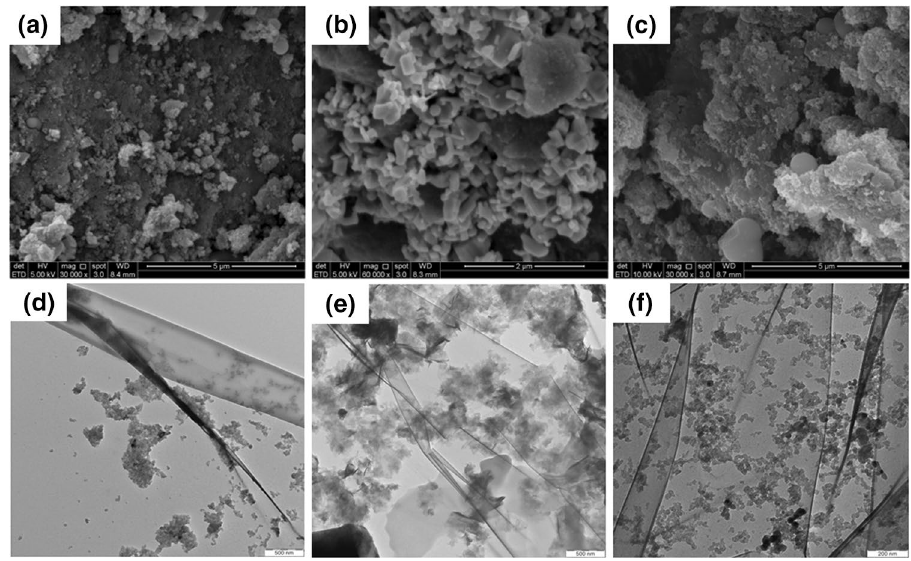
Fig. 4 SEM images of a GO b GO-ZnO composite c GO-TiO 2 composite and TEM images